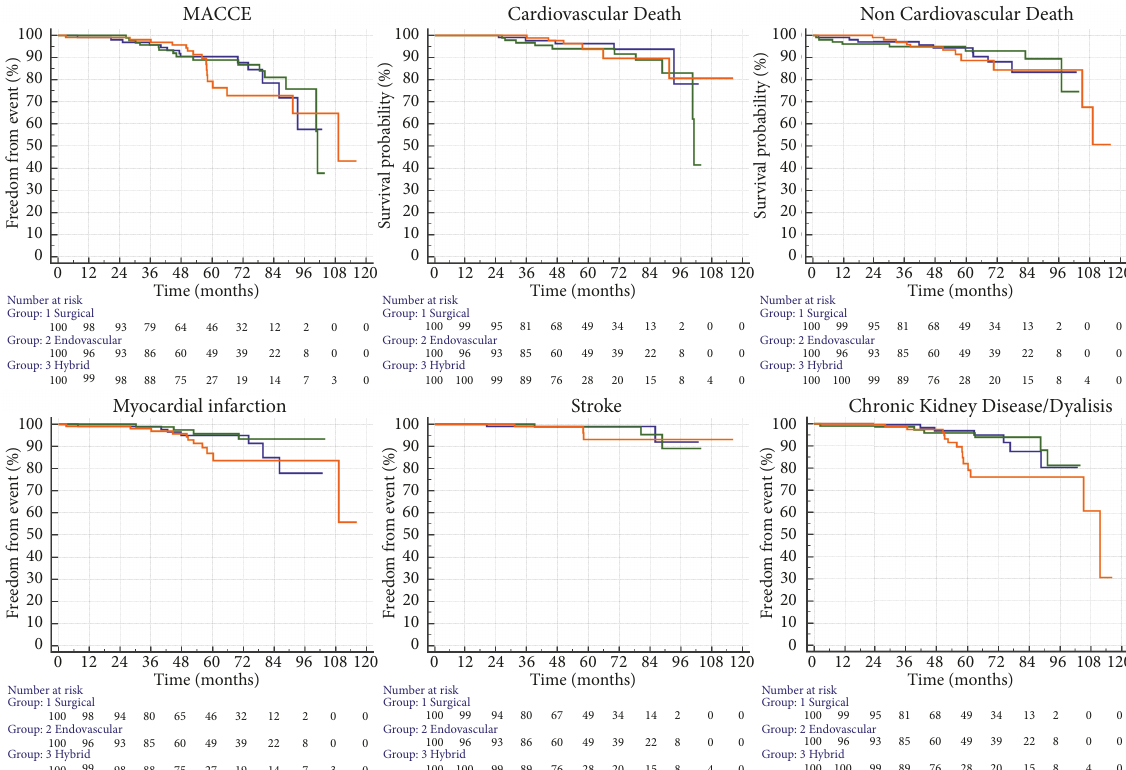
Figure 2: Kaplan-Meier curves for the 5-year primary and secondary endpoints after propensity score matching. The Kaplan-Meier curves for the 5-year primary and secondary endpoints after propensity score matching are shown for the 3 approaches. Blue lines represent the surgical group (1), green lines the endovascular group, (2) and orange lines the hybrid group